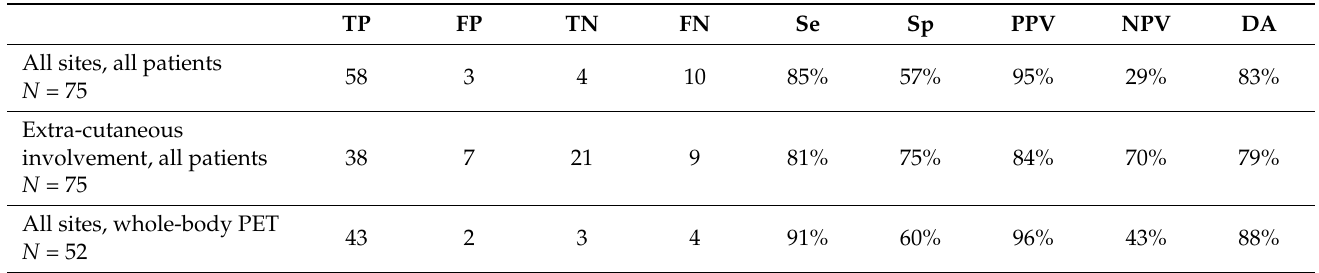
Table 3. Per patient analysis of diagnostic performance for FDG